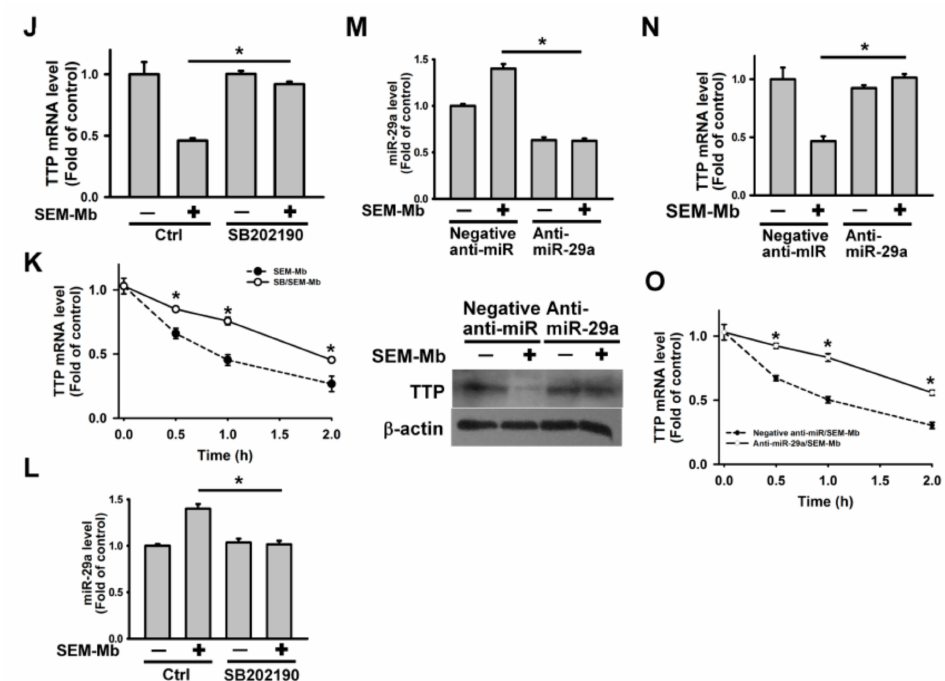
Figure 5. Inhibition of TTP expression by p38 MAPK prolonged the half-life of TNF- α mRNA in SEM-Mb-treated U937 cells. U937 cells were directly treated with 1.5 µ M SEM-Mb for 24 h or pre-treated with 10 µ M SB202190 for 1 h and then incubated with 1.5 µ M SEM-Mb for 24 h. ( A ) Effect of SEM-Mb on PP2Ac α and TTP protein expression. ( B ) Effect of SEM-Mb on the lu- ciferase activity of TTP promoter. After transfection with pGL3-TTP for 24 h, the transfected cells were treated with 1.5 µ M SEM-Mb for 24 h and then harvested for measuring luciferase activity (mean ± SD, NS, not statistically significant). ( C ) qRT-PCR analyses of TTP mRNA levels in SEM- Mb-treated cells (mean ± SD, * p < 0.05). ( D ) Effect of SEM-Mb treatment on TTP mRNA stability. Cells were treated with or without 1.5 µ M SEM-Mb for 24 h, and then incubated with 10 µ g/mL actinomycin D for the indicated time periods. The levels of TTP mRNA were analyzed by qRT-PCR (mean ± SD, * p < 0.05). ( E ) Overexpression of TTP attenuated SEM-Mb-induced TNF- α upregula- tion. After transfection with an empty vector or pCMV-TTP-HA for 24 h, the transfected cells were treated with 1.5 µ M SEM-Mb for 24 h. ( F ) Effect of TTP overexpression on TNF- α mRNA levels in SEM-Mb-treated cells (mean ± SD, * p < 0.05). ( G ) Effect of SEM-Mb treatment on TNF- α mRNA stability in pCMV-TTP-HA-transfected cells. The empty vector- and pCMV-TTP-HA-transfected cells were treated with 1.5 µ M SEM-Mb for 24 h, and then incubated with 10 µ g/mL actinomycin D for the indicated time periods. The levels of TNF- α mRNA were analyzed by qRT-PCR (mean ± SD, * p < 0.05). ( H ) Overexpression of TTP rescued the viability of SEM-Mb-treated cells (mean ± SD, * p < 0.05). ( I ) Effect of SB202190 on TTP expression in SEM-Mb-treated cells. ( J ) Effect of SB202190 on TTP mRNA levels in SEM-Mb-treated cells. The levels of TTP mRNA were analyzed by qRT-PCR (mean ± SD, * p < 0.05). ( K ) Effect of SB202190 on TTP mRNA turnover in SEM-Mb-treated cells. U937 cells were pre-treated with 10 µ M SB202190 for 1 h, and then incubated with 1.5 µ M SEM-Mb for 24 h. SEM-Mb- and SB202190/SEM-Mb-treated cells were incubated with 10 µ g/mL actinomycin D for the indicated time periods (mean ± SD, * p < 0.05). ( L ) Effect of SB202190 on the expression of miR-29a in SEM-Mb-treated cells (mean ± SD, * p < 0.05). ( M ) Transfection of anti-miR-29a inhibited SEM-Mb-induced TTP downregulation. Cells were transfected with negative control anti- miR or anti-miR-29a. After 24 h post-transfection, the cells were treated with 1.5 µ M SEM-Mb for 24 h. (Top panel) qRT-PCR analysis of miR-29a levels in anti-miR-29a-transfected cells (mean ± SD, * p < 0.05). (Bottom panel) Western blot analysis of TTP expression in anti-miR-29a-transfected cells after SEM-Mb treatment. ( N ) Transfection of anti-miR-29a increased the expression of TTP mRNA in SEM-Mb-treated cells. The negative control anti-miR- and anti-miR-29a-transfected cells were